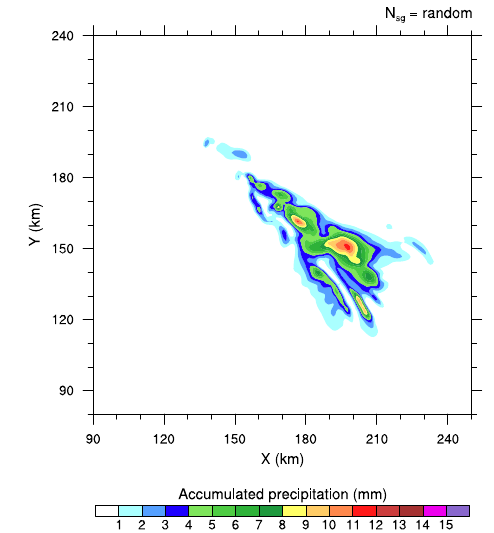
Figure 2. As in Fig. 1 but for the “RANDOM”